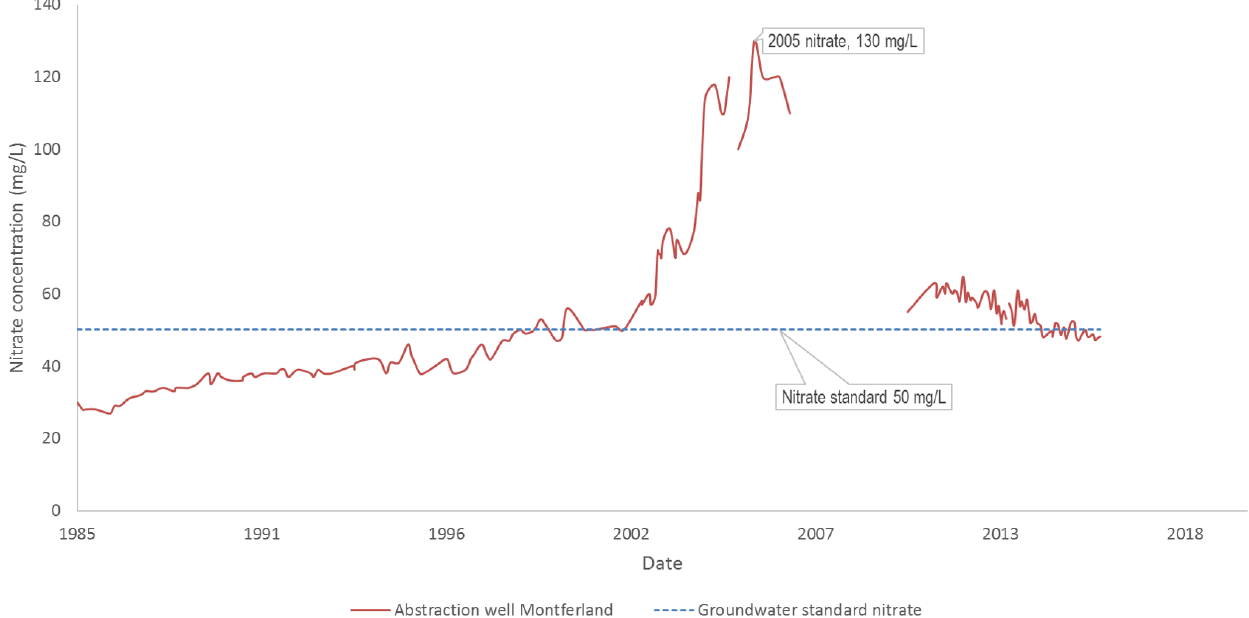
Figure 2. Development of nitrate in an abstraction well in Montferland (HEE-P07-07.0; coordinates – X213.540–Y434.761) in the province of Gelderland, the Netherlands (Van Engelenburg et al., unpublished, 2020), compared to the Dutch standard for nitrate concentration in groundwater (50mgL − 1 ).